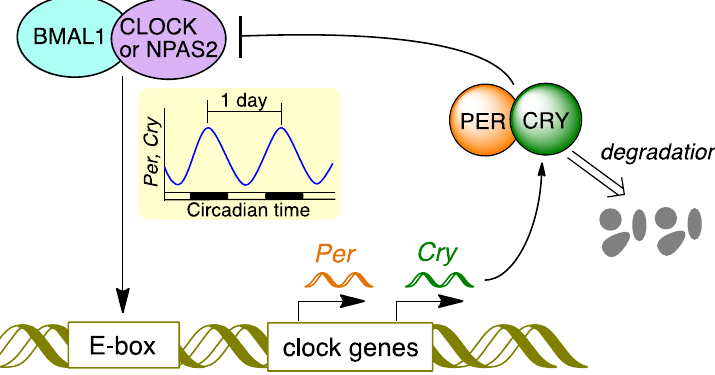
Figure 1. The core transcription-translation feedback loop in the circadian system of mammalian cells. The components of Fig. 1 were drawn using